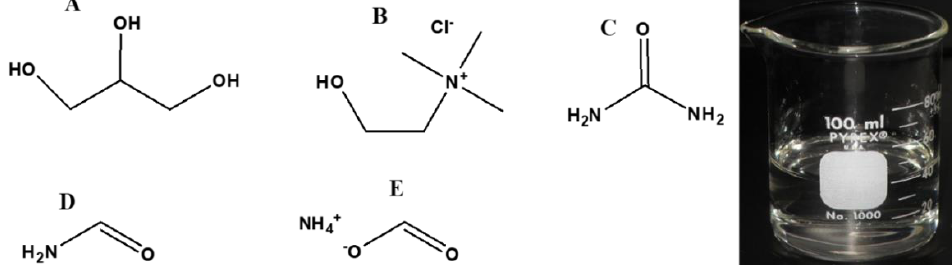
Figure 9. Key components of non-aqueous and semi-aqueous solvents are shown [113–115]: (A) glycerol, (B) choline chloride, (C) urea, (D) formamide, and (E) ammonium formate, respectively. The glass beaker shows the formation of deep eutectic solvent formed when C and B (2:1) are mixed and heated with constant stirring at 80 °C.